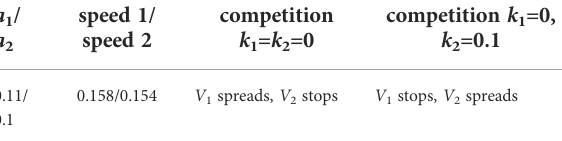
TABLE 2 Competition of two virus variants with or without the immune response. a 1 / a 2